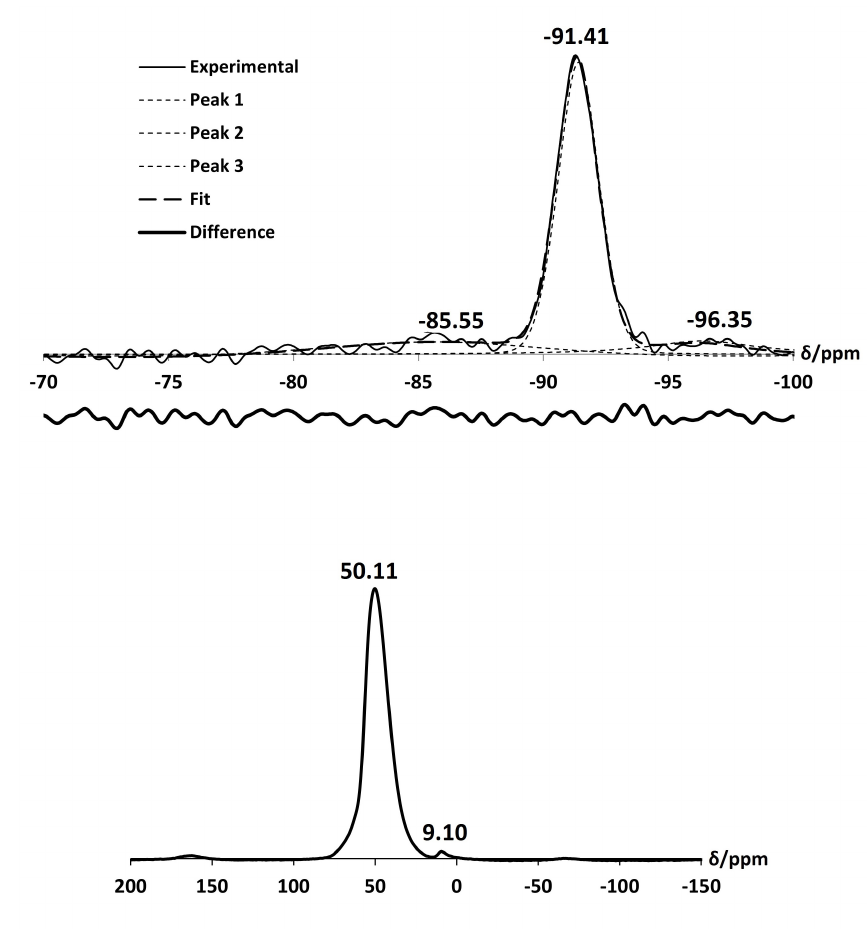
Figure 13. 29 Si (top) and 27 Al (bottom) NMR spectrum of the divalent cation-exchanged